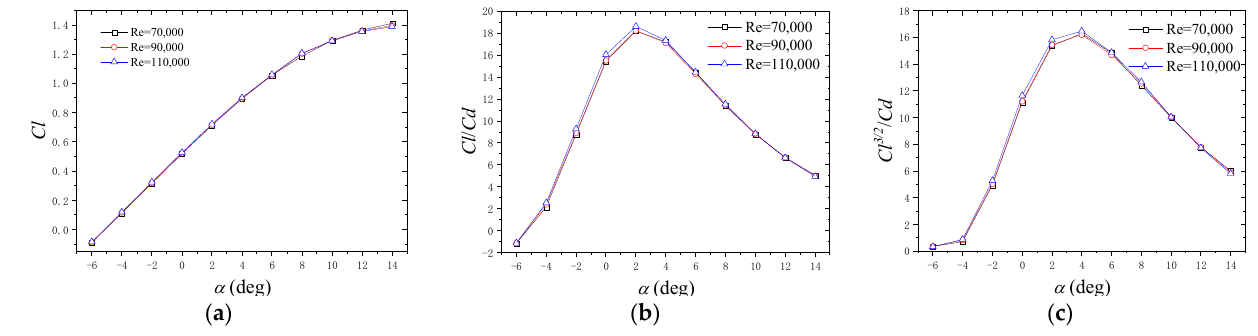
Figure 5. Aerodynamic performance of C5.5/4.5 airfoil. ( a ) Cl; ( b ) Cl/Cd; ( c ) Cl 3/2 /Cd.